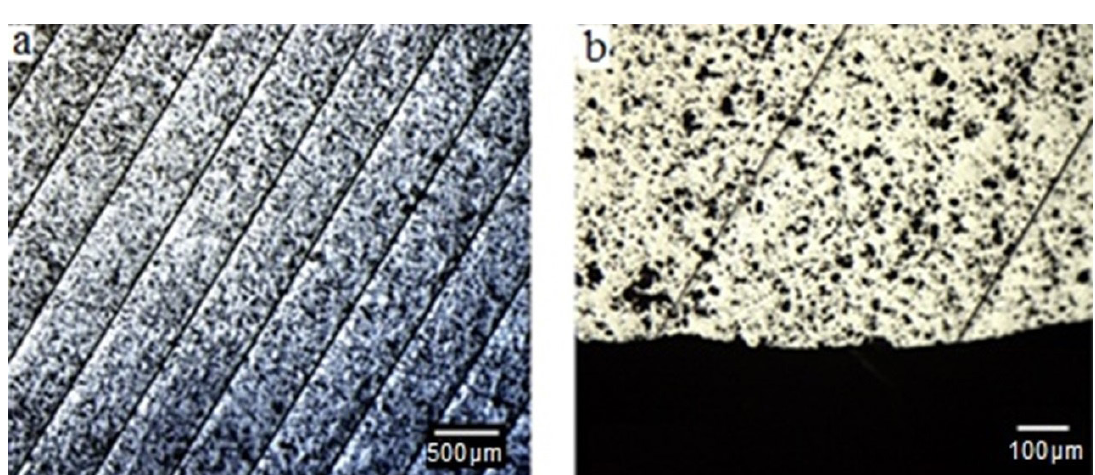
Figure 5. Light micrographs of the ductility streaks after 4 h of machining.